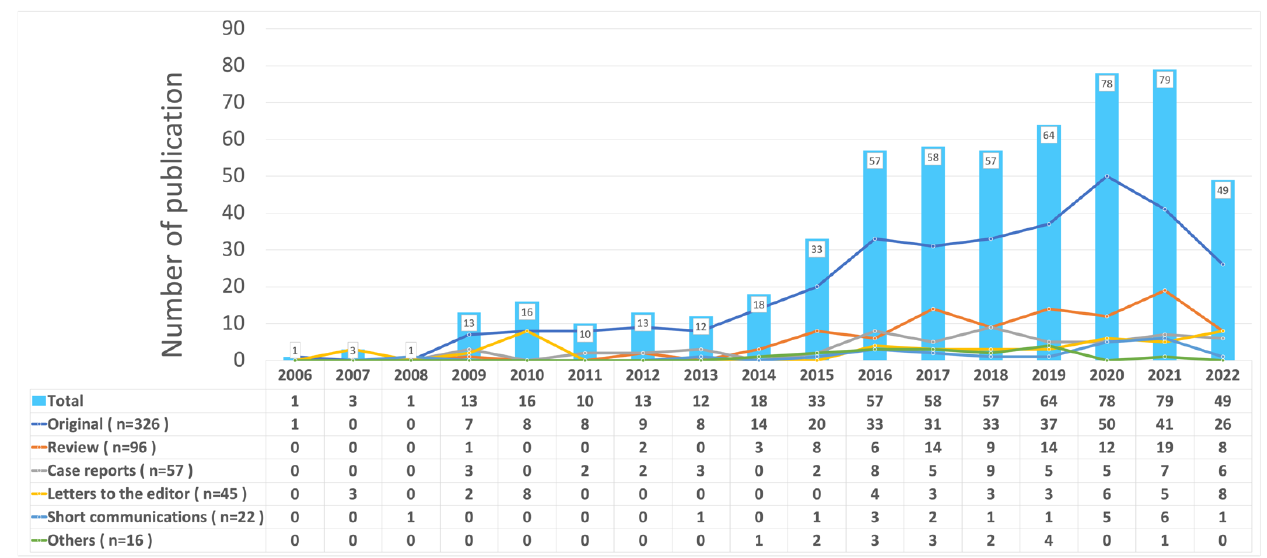
Figure 2. The annual production of different article types in PRF studies.